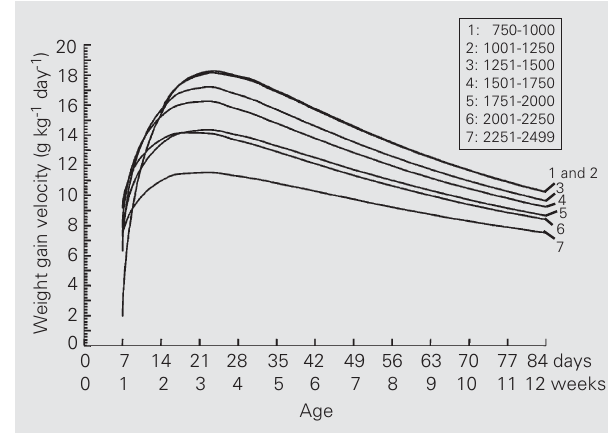
Figure 3. Mean daily weight gain velocity (g/day) of preterm newborns by birth weight category.